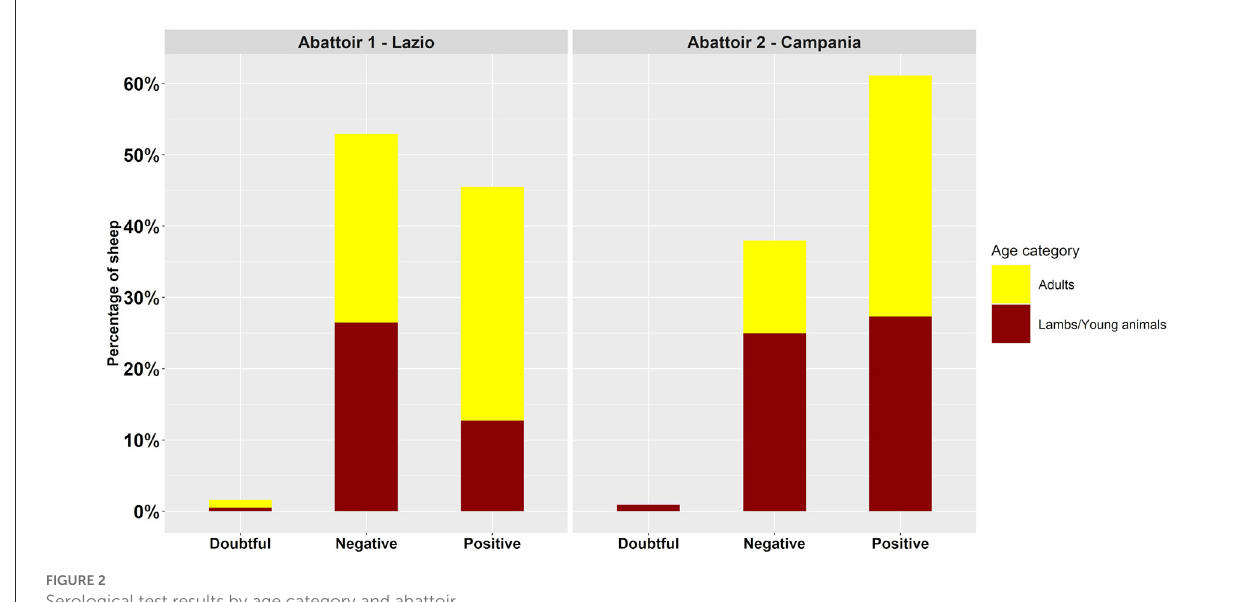
FIGURE2 Serological test results by age category and abattoir.